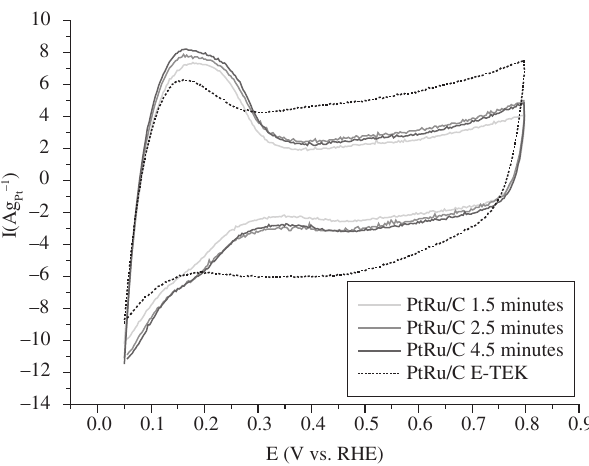
Figure 3. Cyclic voltammograms of PtRu/C electrocatalyst prepared using electron beam irradiation (4.5 minutes) in 0.5 mol.L –1 H ferent concentrations of methanol with a sweep rate of 10 mV.s –1 .